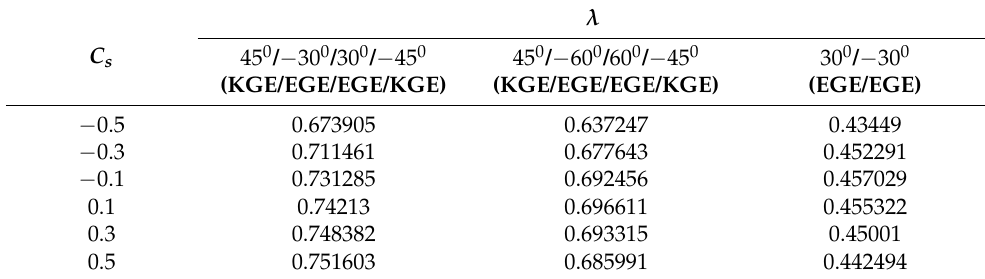
Table 4. Relation of sinusoidal thickness variation C s and the fundamental frequency parameter λ . n = 2, γ = 0.05 and β = 0.5.